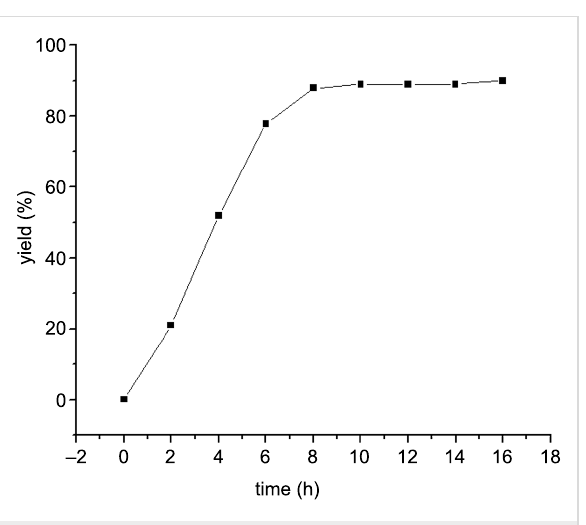
Figure 3: Dependence of the yield of compound 4a on the reaction time using BATA-MC.